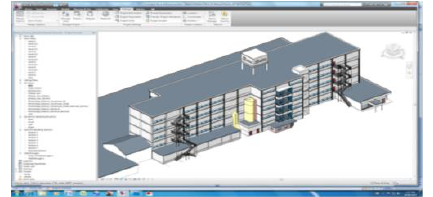
Figure 4. Final HBIM Model of factory (Fai et al., 2011)